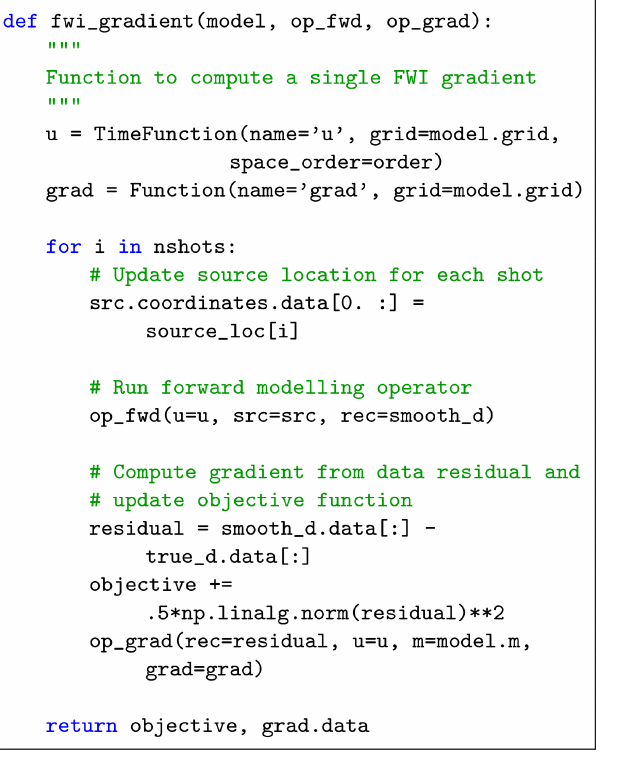
Figure 7. Definition of FWI gradient update.